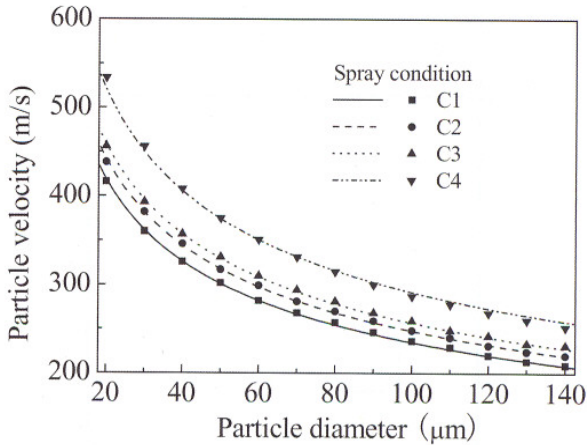
Figure 8: Particle velocity vs. Particle diameter for different gas conditions